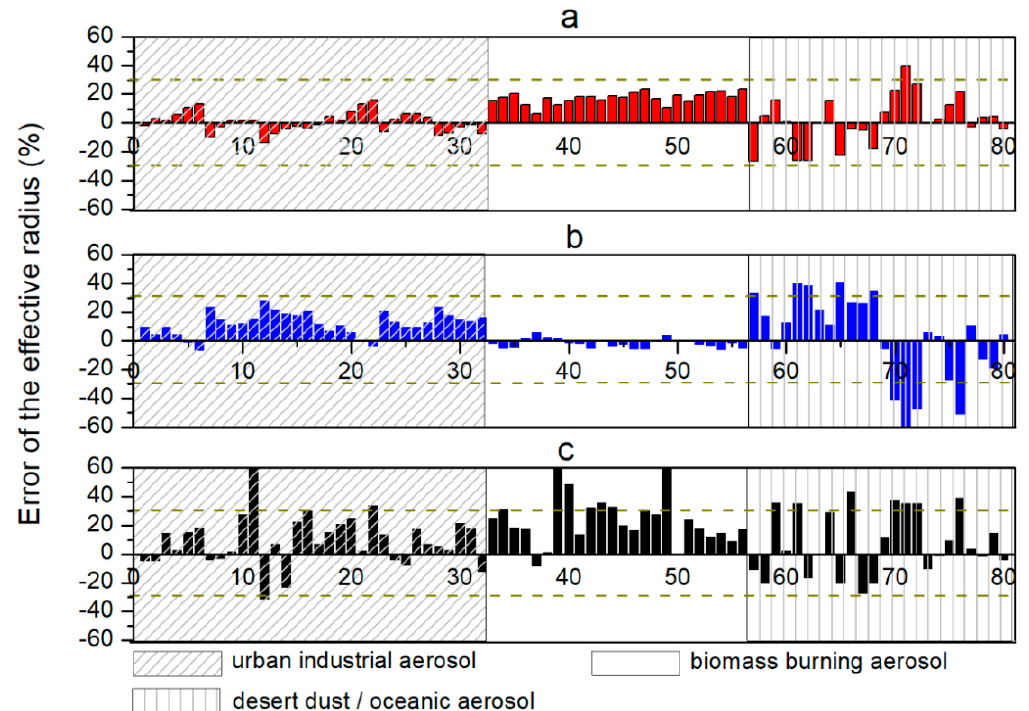
Figure 4. Inversion error of the effective radius. ( a ) error of the effective radius from the error-free data (red columns); ( b ) error of the effective radius from the data with 10% systematic error (blue columns); ( c ) error of the effective radius from the data with 15% random error (black columns).